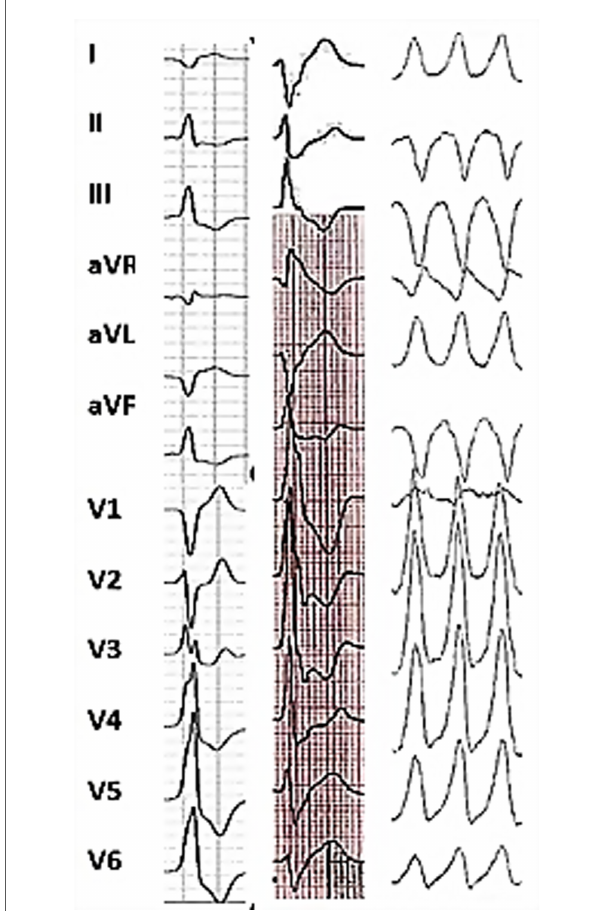
FIGURE 2 Representative 12-lead surface ECG illustrating multifocal ventricular arrhythmias in the same patient. Frequent premature ventricular complexes of 2 different morphologies were recorded: the fi rst one showing left bundle branch block con fi guration, V3 transition and inferior axis consistent with an out fl ow tract site and the second one with right bundle branch block morphology, V5 transition and D2/D3 negative/positive discordance (meaning an opposite depolarization vector along bipolar limb leads II and III being equivalent to a frontal axis of +150 to +210°) suggesting the origin from the anterolateral papillary muscle. Sustained monomorphic ventricular tachycardia (on the right) with a right bundle branch block con fi guration and superior axis pointing towards the postero-basal left ventricular wall origin was induced with programmed electrical